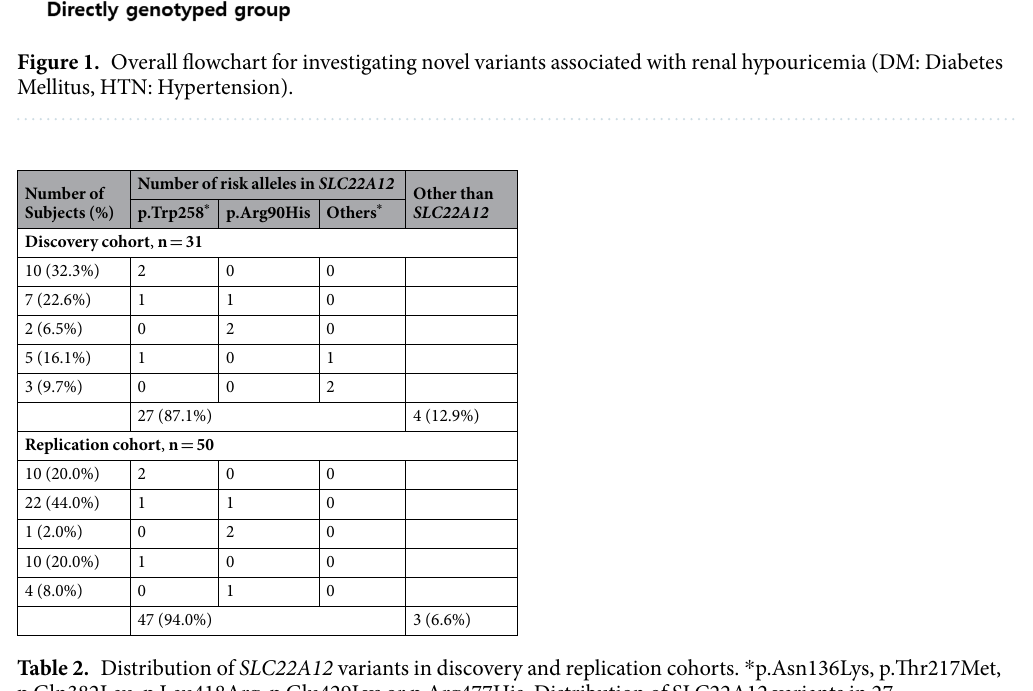
Table 2. Distribution of SLC22A12 variants in discovery and replication cohorts. * p.Asn136Lys, p.Thr217Met, p.Gln382Leu, p.Leu418Arg, p.Glu429Lys or p.Arg477His. Distribution of SLC22A12 variants in 27 hypouricemia individuals out of 31 in discovery